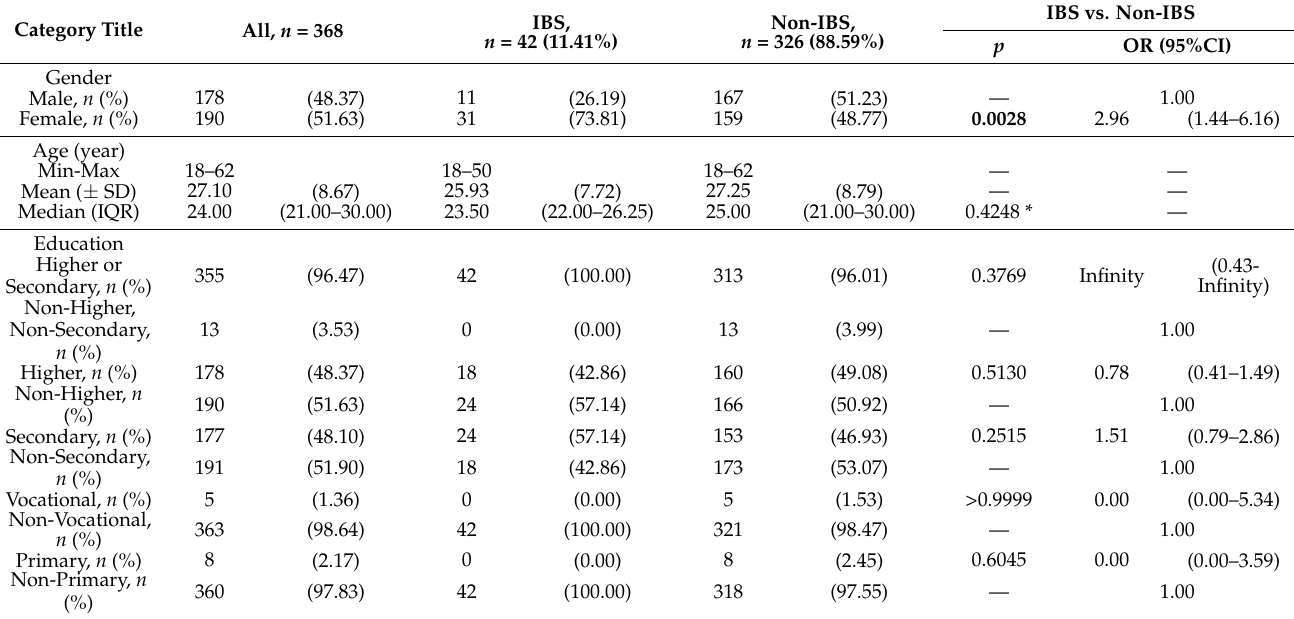
Table 1. Demographic data and the analysis of age, gender, and education on IBS